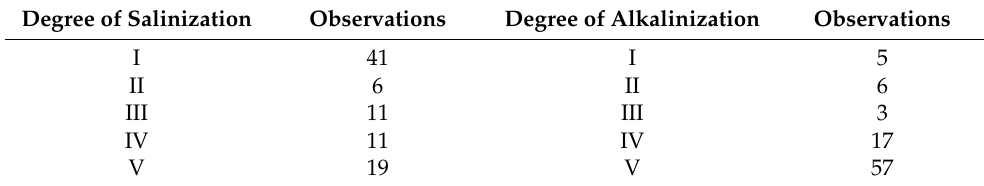
Table 3. The number of observations in different levels. Degree of